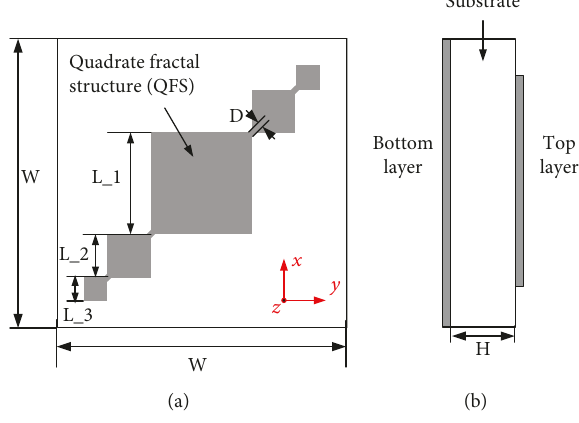
Figure 1: Geometry of the PCM unit cell: (a) Top view; (b) side view.